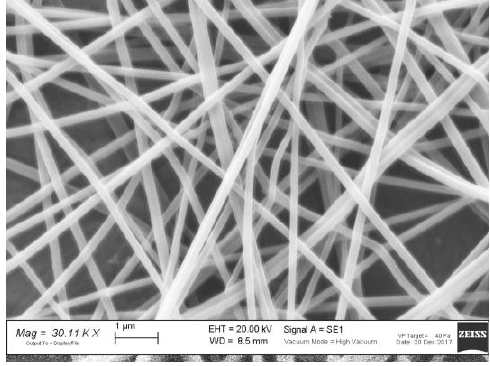
Figure 3. SEM micrograph of ALG/l-PEO fibers.